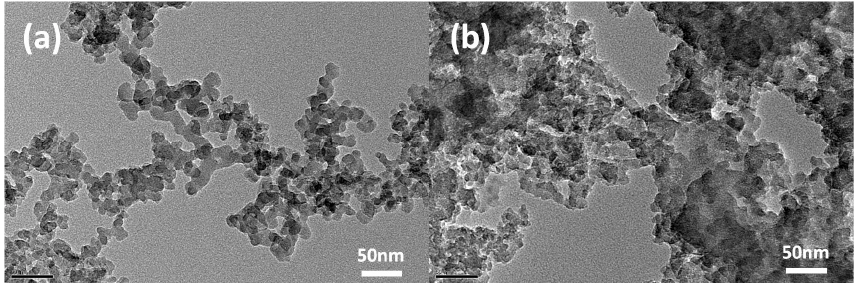
Figure 1. Transmission electron microscopy (TEM) image of ( a ) polydimethylsiloxane (PDMS)-SiO 2 and ( b ) PDMS-SiO 2 /PFA with a mass ratio of PDMS-SiO 2 to PFA of 0.5.